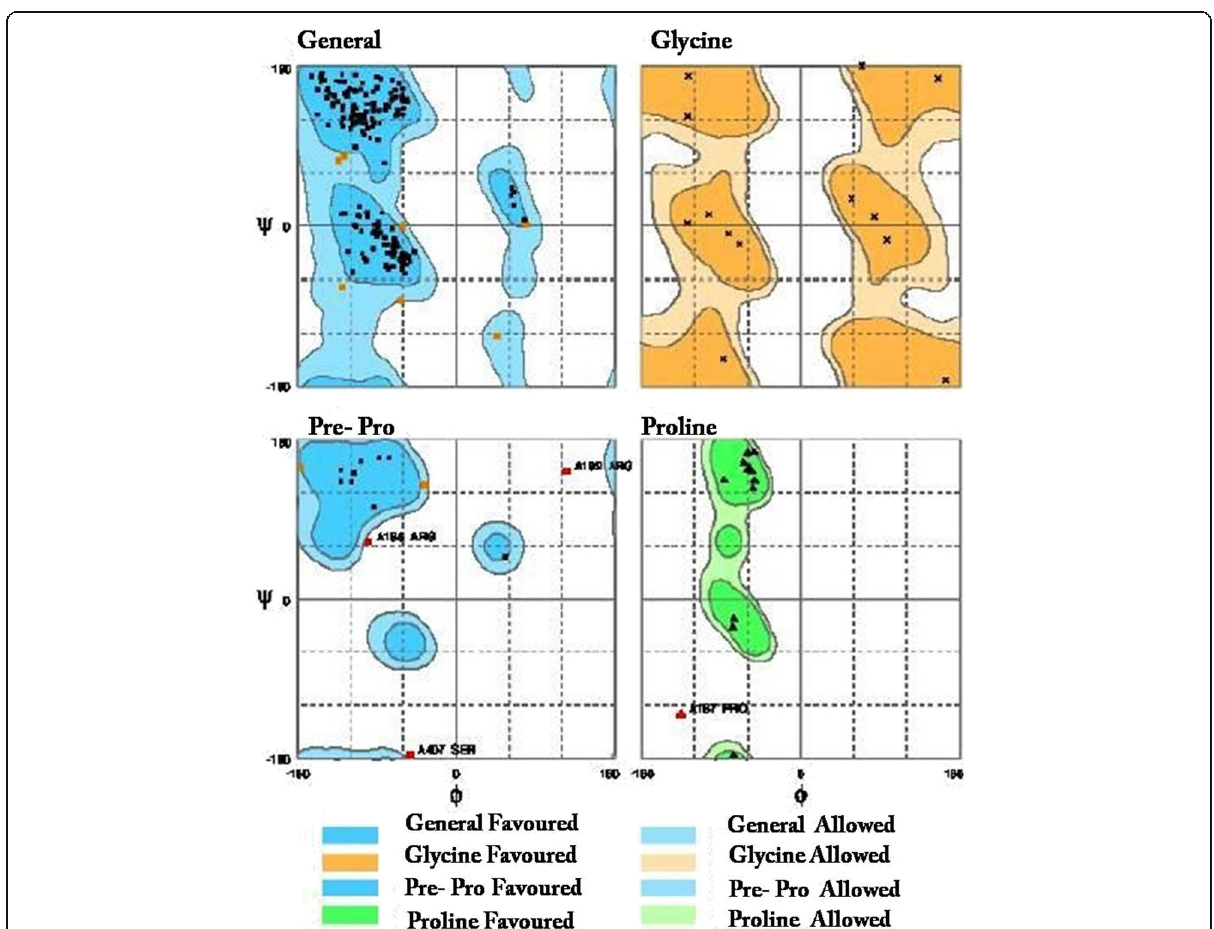
Fig. 7 Structure Validation by Ramachandran plot depicts the general as well as specific distribution of amino acids. A total of 94.2% of amino acids were in favored and 2.23% were outliers suggesting higher degree of the stability of the predicted protein